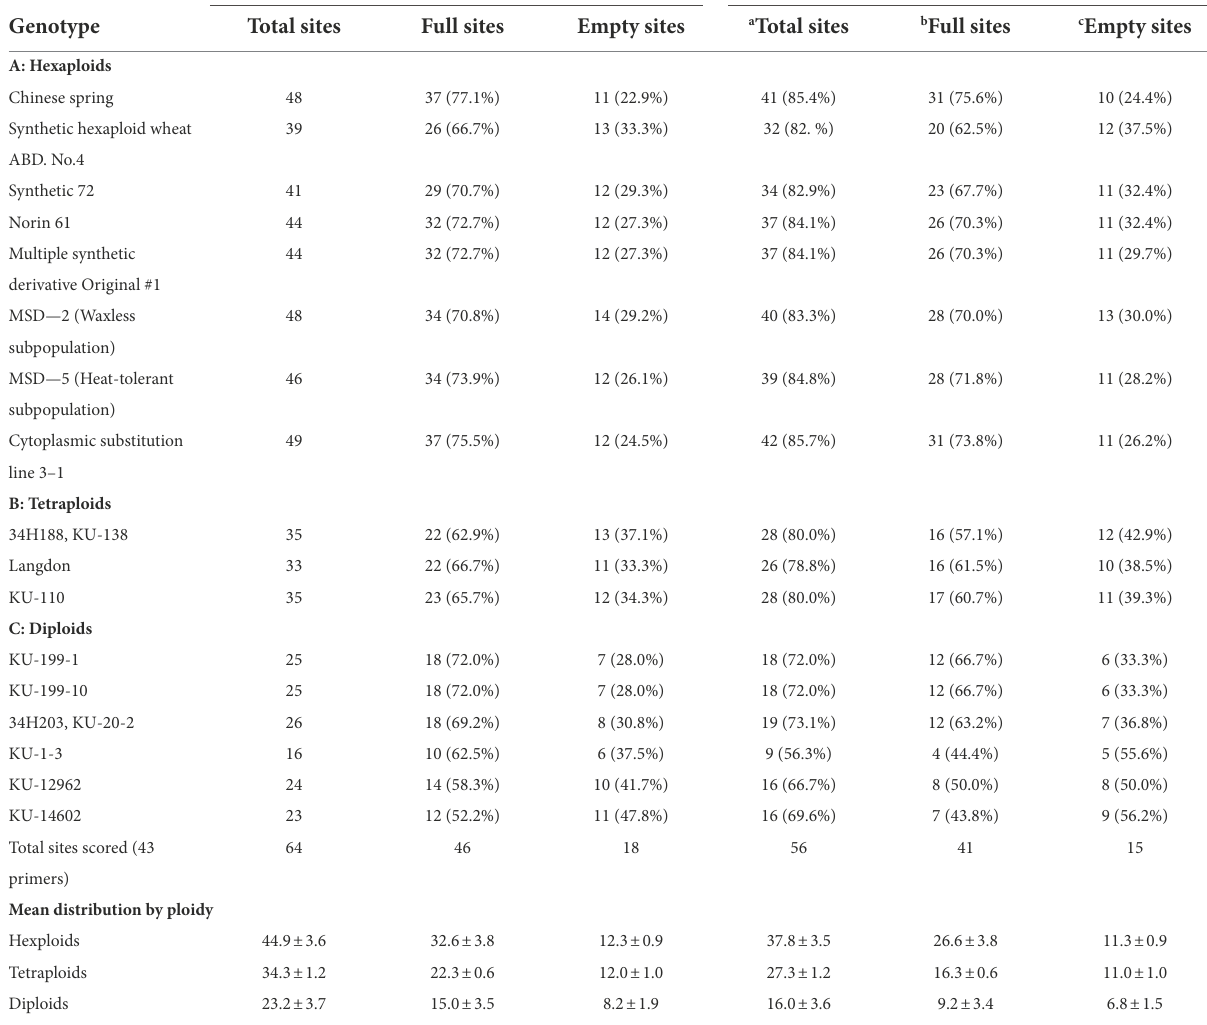
TABLE 3 Distribution of amplified MITE fragments in 17 accessions of wheat and related species. No. amplified